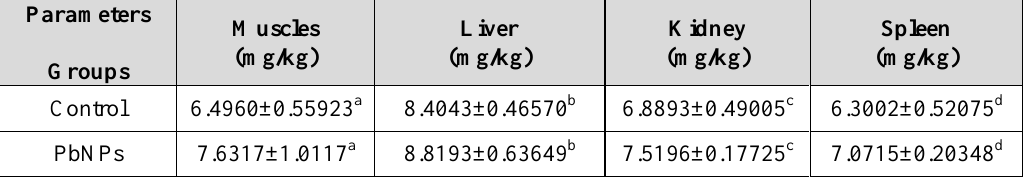
Table 1: Lead bioaccumulation in the organs of rats. In control and exposed animals to PbNPs.